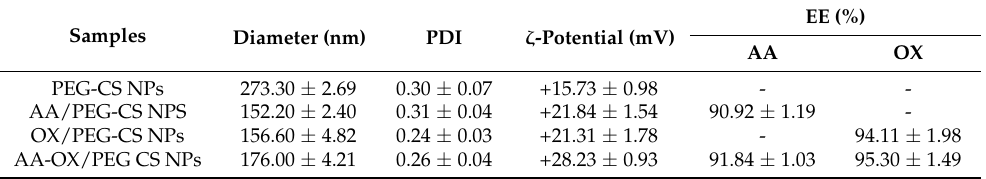
Table 2. Characterization of PEG-CS NPs, AA/PEG-CS NPs, OX/PEG-CS NPs, and AA-OX/PEG-CS NPs. Data represent means ± SD ( n =